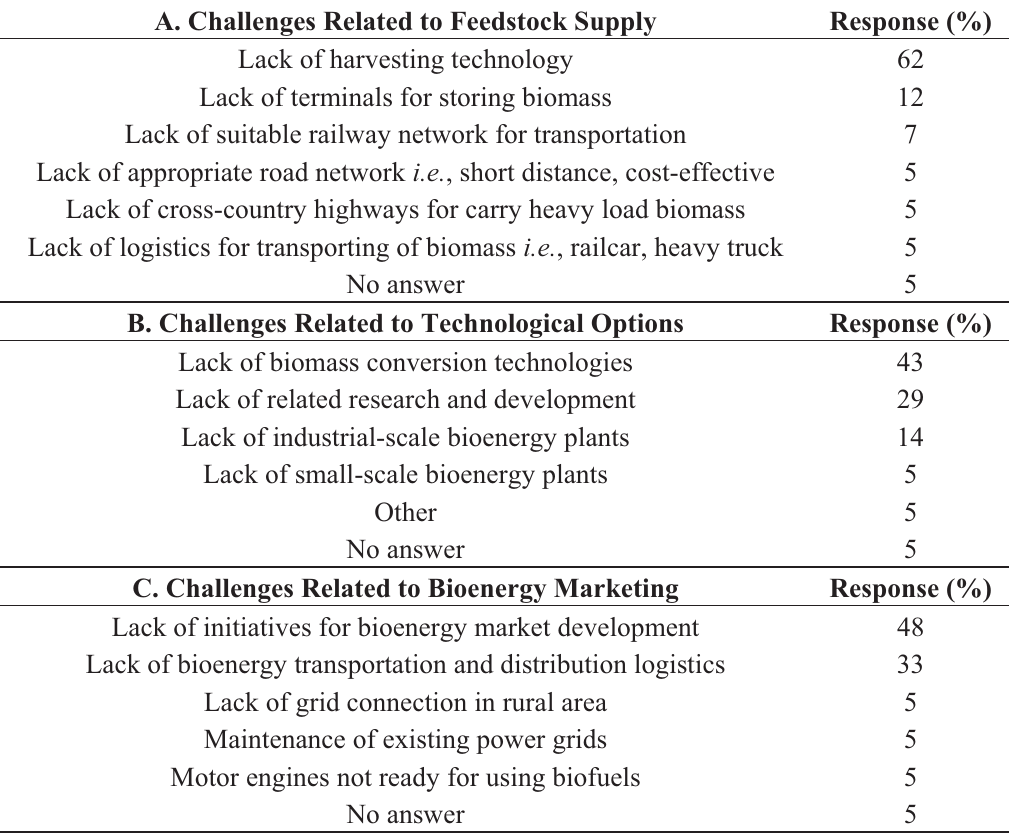
Table 8. Respondents’ perception on challenges involved in modernization of bioenergy technologies in